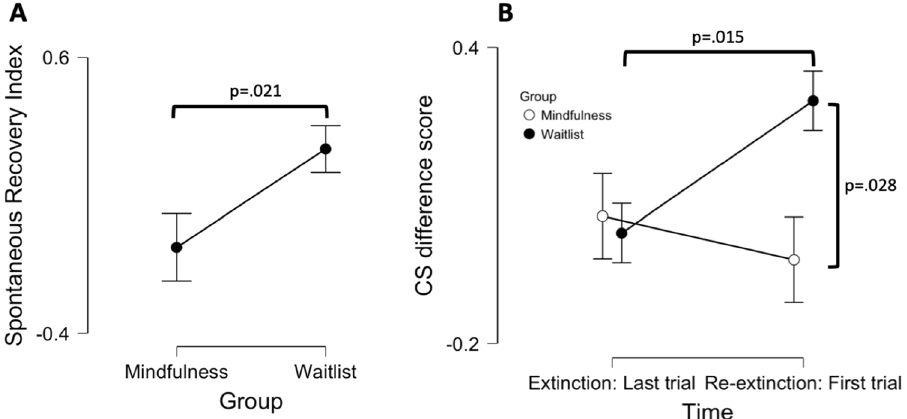
Figure 4. Mindfulness training enhances extinction retention. ( A ) In order to evaluate between-group differences in extinction retention a spontaneous recovery index (SRI) was calculated by deducting the CS elicited threat response at the last trial of extinction from the first trial of re-extinction. An independent t-test confirmed a significant group difference on the SRI where the control group (n = 15) showed clear indications of recovery whereas no recovery was observed in subjects that had undergone MFT (n = 11). ( B ) This effect was driven by differential responding to the conditioned stimuli at the beginning of the re-extinction phase rather than the end of the extinction phase. A significant between group difference in magnitude of threat responses was observed during the first trial of re-extinction but not during the last trial of extinction, and the control group, but not the mindfulness group, showed significant increases in threat responses from the end of extinction to the beginning of re-extinction. Displayed p-values were obtained through Wilcoxon Signed-Rank Test and independent t-test respectively. Points and error bars denote means and